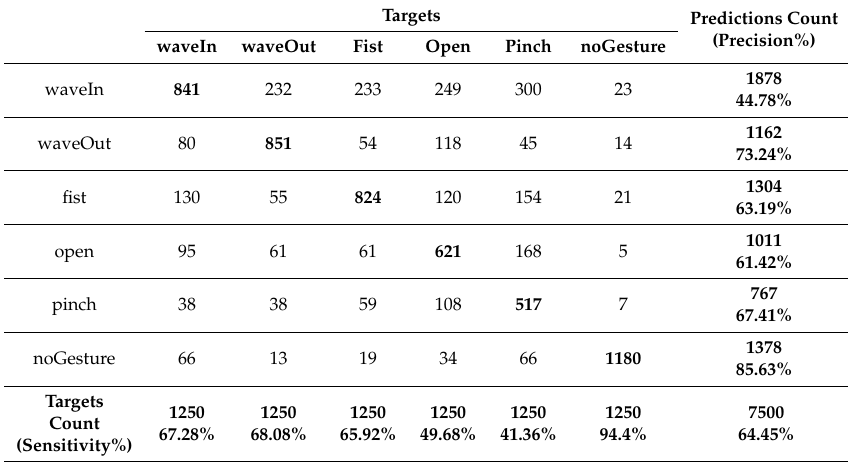
Table A3. Confusion matrix of waveIn sync gesture for the user-general HGR